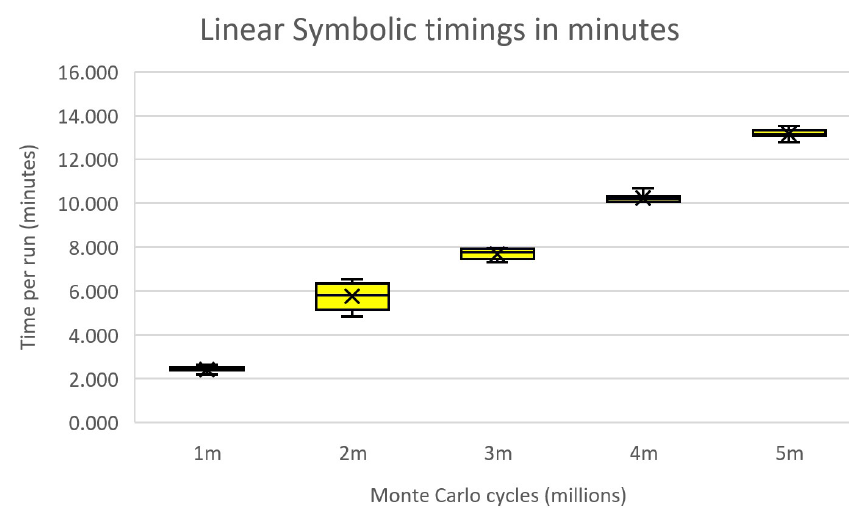
Figure 6. Box plot timings for linear symbolic optimisation: 10 runs in each case.